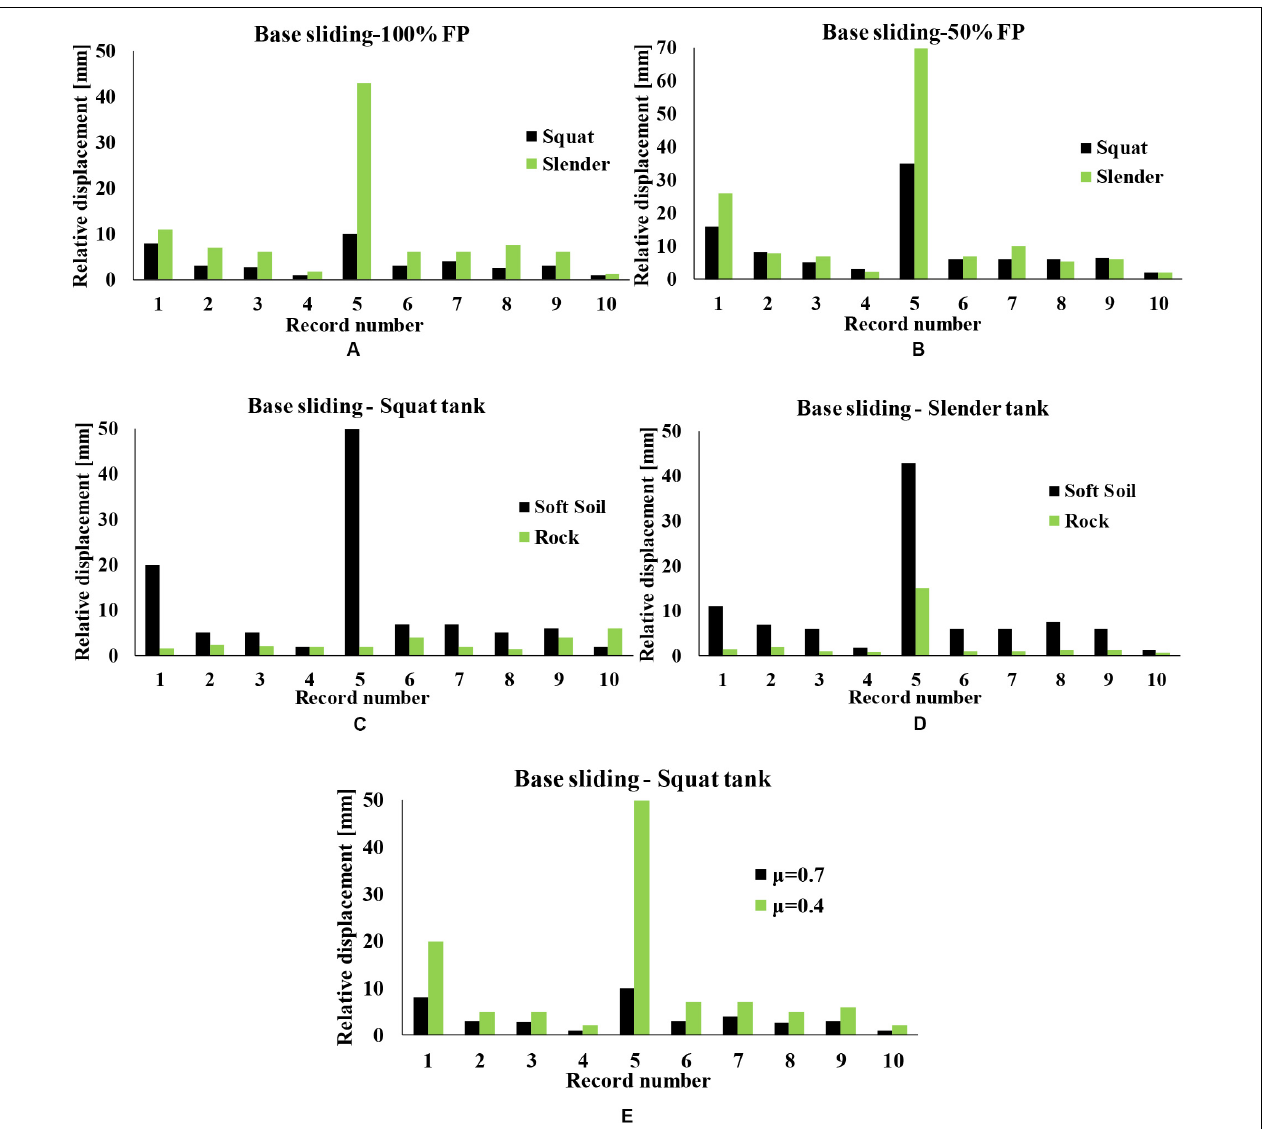
FIGURE 9 | Base sliding results of (A) 100% FP and (B) 50% squat and slender tank, (C) squat and (D) slender tank for different foundation layer types, and (E) comparison of friction coefficient for the unanchored squat tank.